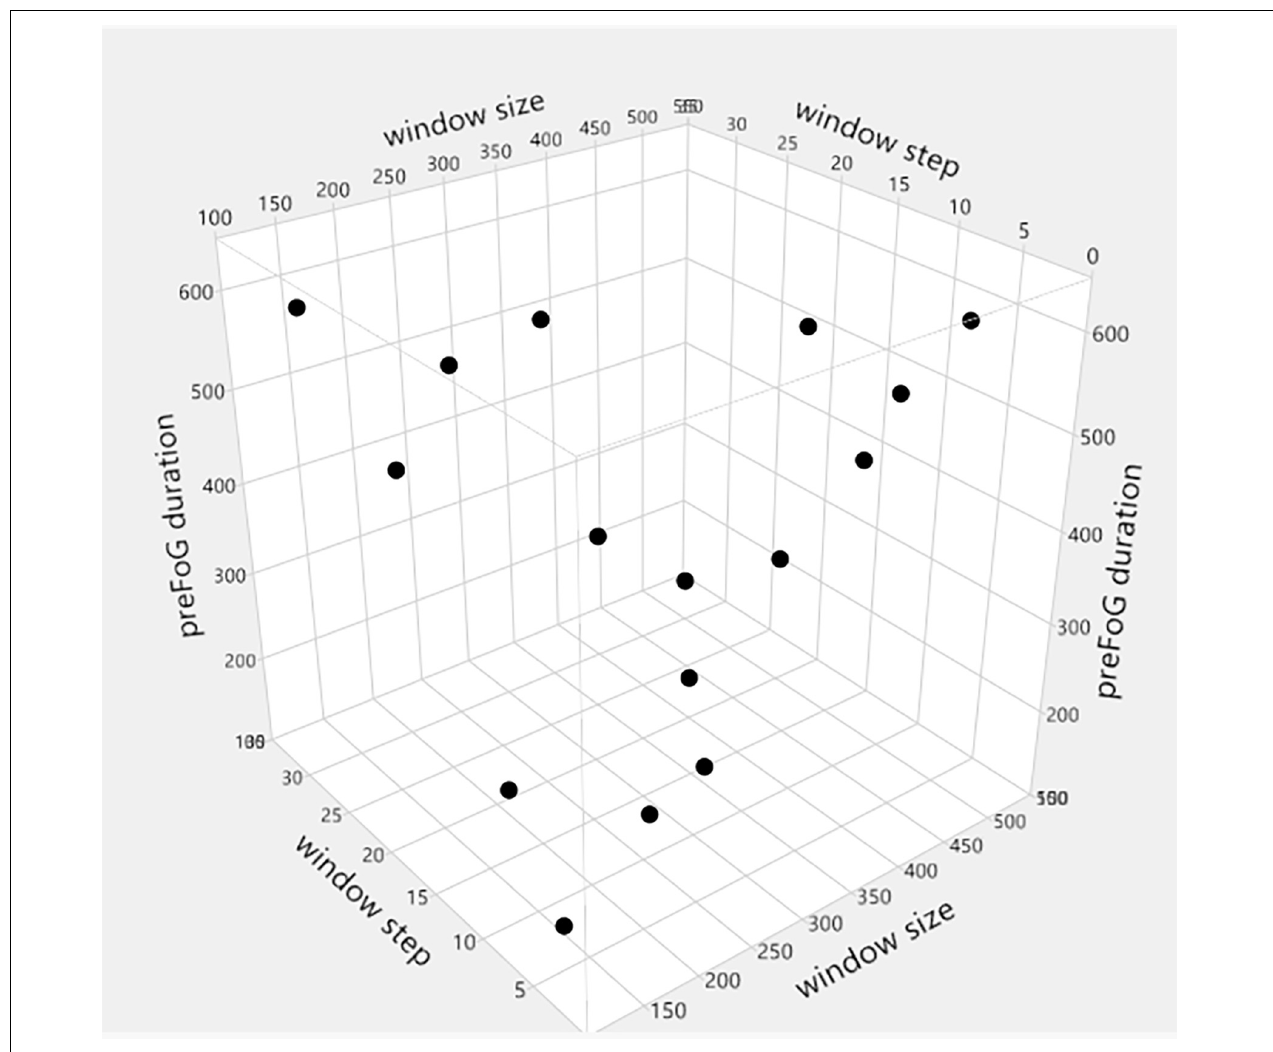
FIGURE 4 | L 16 (4 3 ) orthogonal experimental design